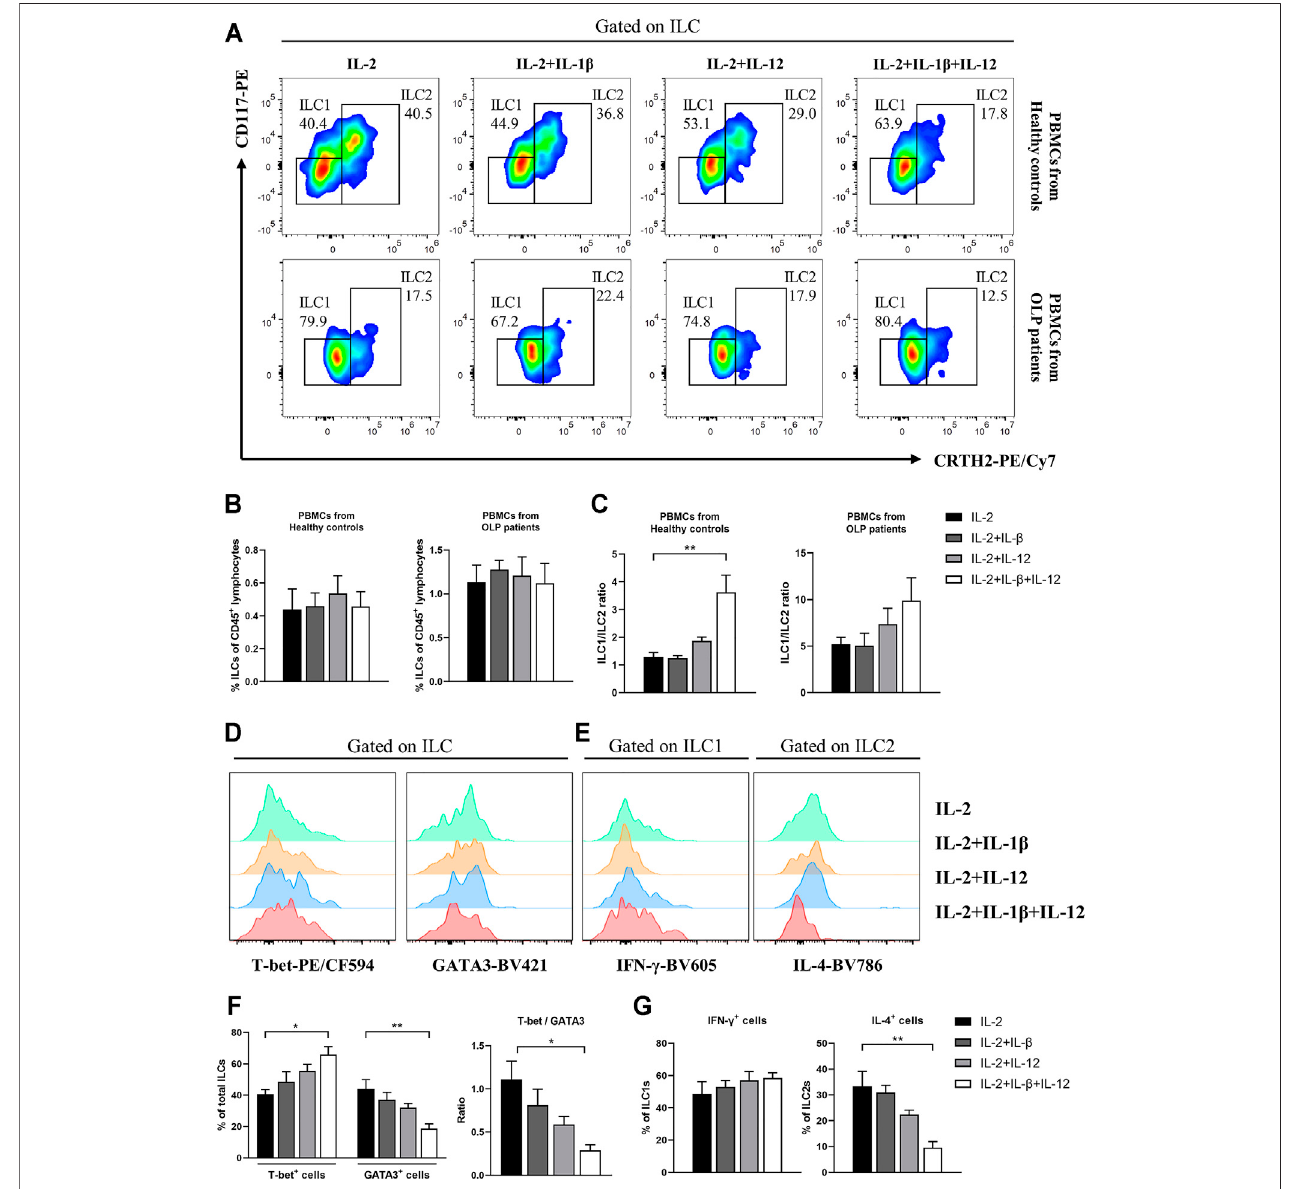
FIGURE 7 | In vitro IL-12/IL-1 β stimulation test. PBMCs collected from healthy controls and OLP patients were stimulated with IL-2 alone or with IL-2 and various combinationsofIL-1 β andIL-12for3 days. (A) RepresentativeFACSplotsde fi ningILC1sandILC2s.AsshowninhealthycontrolsandOLPpatients: (B) percentagesof total ILCsinCD45 + lymphocytes; (C) ratioofILC1/ILC2. Asshown inhealthy controls:representative histogramsofintracellular stainingforT-betandGATA3 inILCs (D) as well as IFN- γ in ILC1s and IL-4 in ILC2s (E) ; (F) percentages of T-bet + and GATA3 + cells aswell asratio of T-bet/GATA3 in total ILCs; (G) percentages of IFN- γ + cells in ILC1s and IL-4 + cells in ILC2s. Data are depicted as a bar graph with mean ± SEM. One-way ANOVA was performed, * p < 0.05, ** p < 0.01. PBMCs, peripheral blood mononuclear cells; OLP, oral lichen planus; FACS, fl uorescence-activated cell sorting.